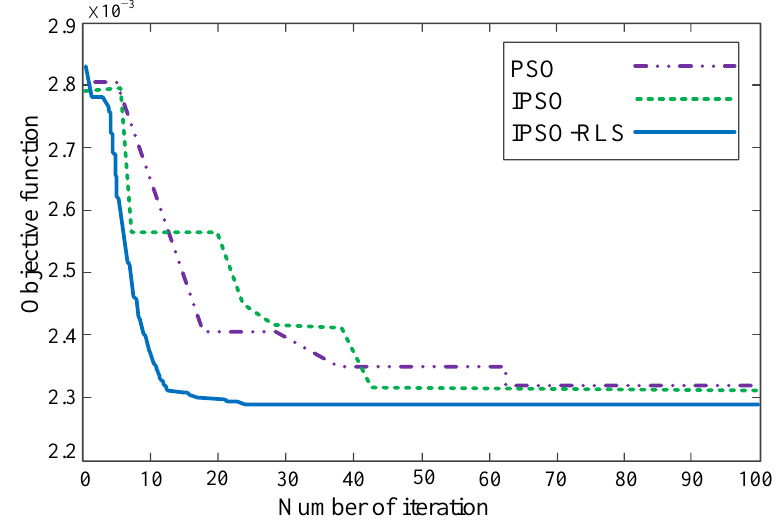
Figure 10. Convergences of the objective function for G best .